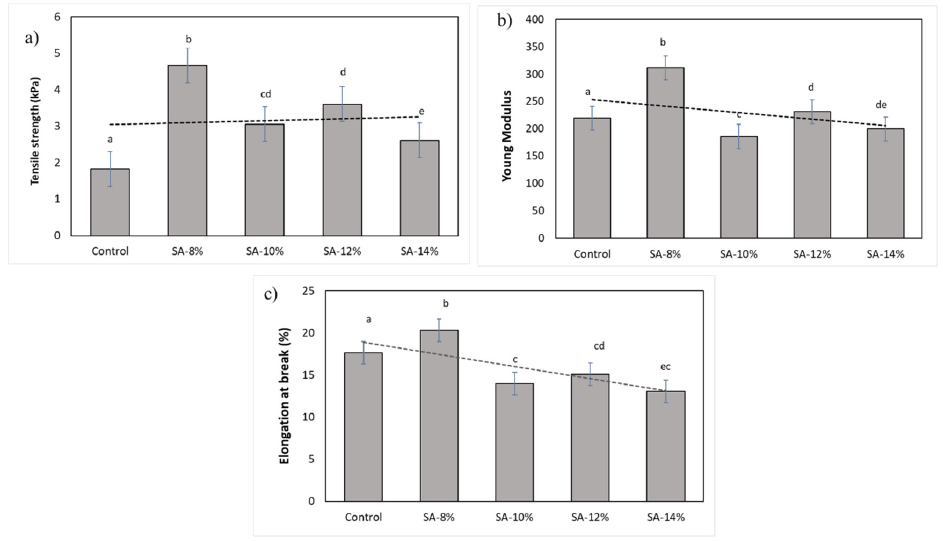
Figure 3. Mechanical properties of the RCA incorporated and control films: ( a ) tensile strength; ( b ) Young Modulus, and ( c ) elongation at break.